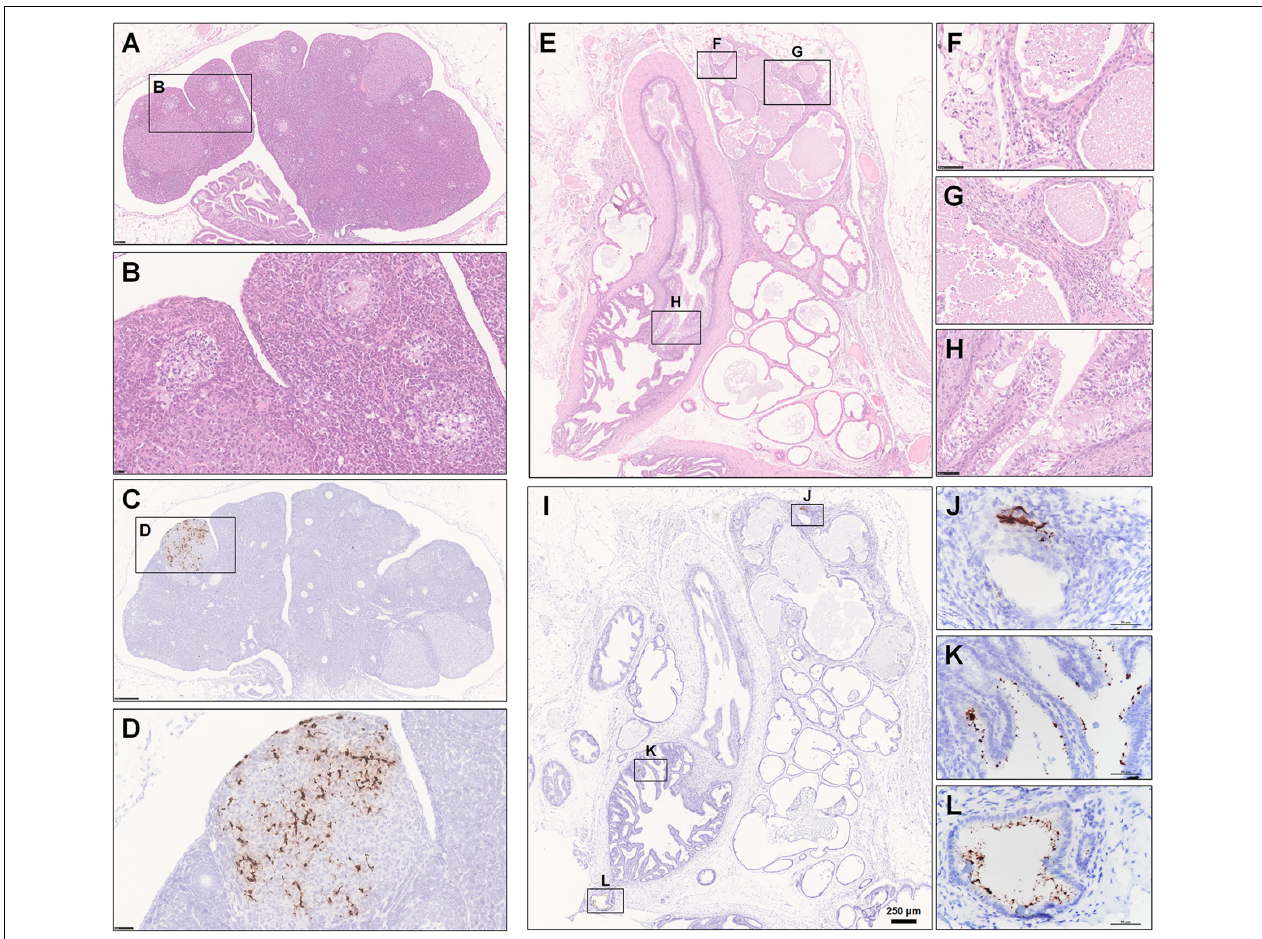
FIGURE 7 | Observation and examination of the reproductive system. (A–H) The female reproductive system at 5 dpi. (A,B) Oophoritis was present, characterized by focal necrosis and the presence of mononuclear cells and lymphocytes in the stromal connective tissue. No mature follicles were found. (C,D) Robust viral RNA expression was detected in the area of the corpus luteum. (E–L) The male accessory sexual gland at 7 dpi. (E–H) Prostatitis and inflammation of the vesicular gland. (I–L) Robust viral RNA expression was detected in a patchy distribution in the interstitium of the prostate and the epithelium of the vesicular glands. Sequential sections were stained by HE and subjected to ISH. Data were representative of three independent